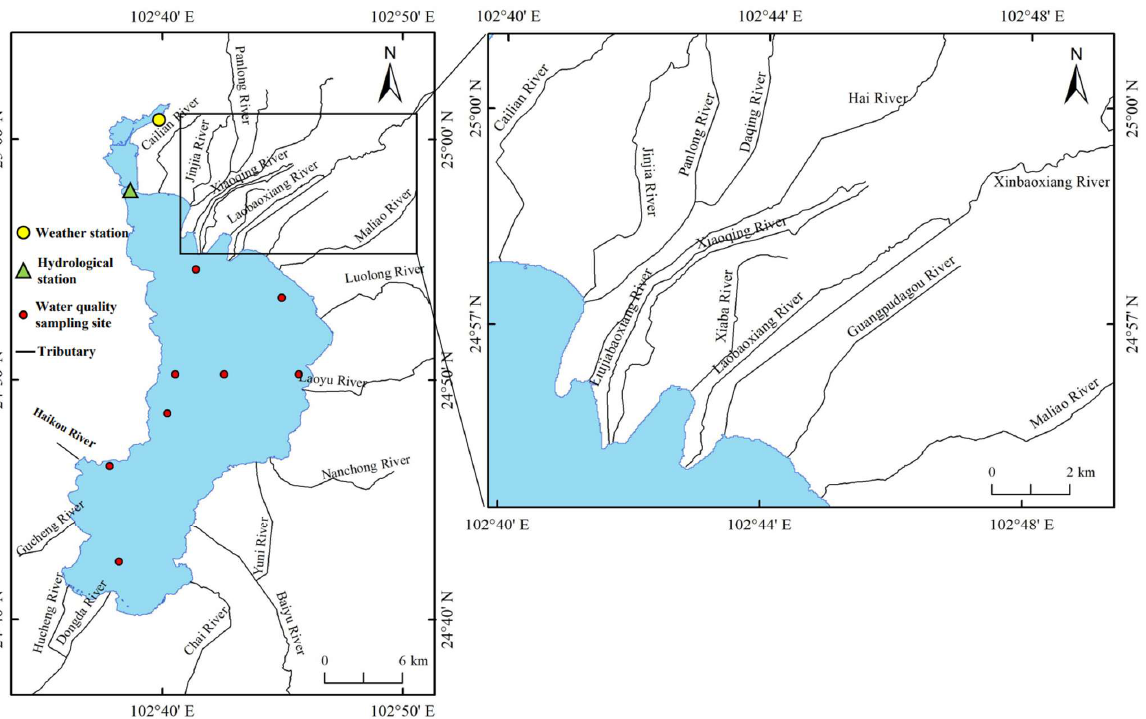
Figure 1. Distribution of meteorological stations, hydrological stations and main tributaries of Lake Dianchi.